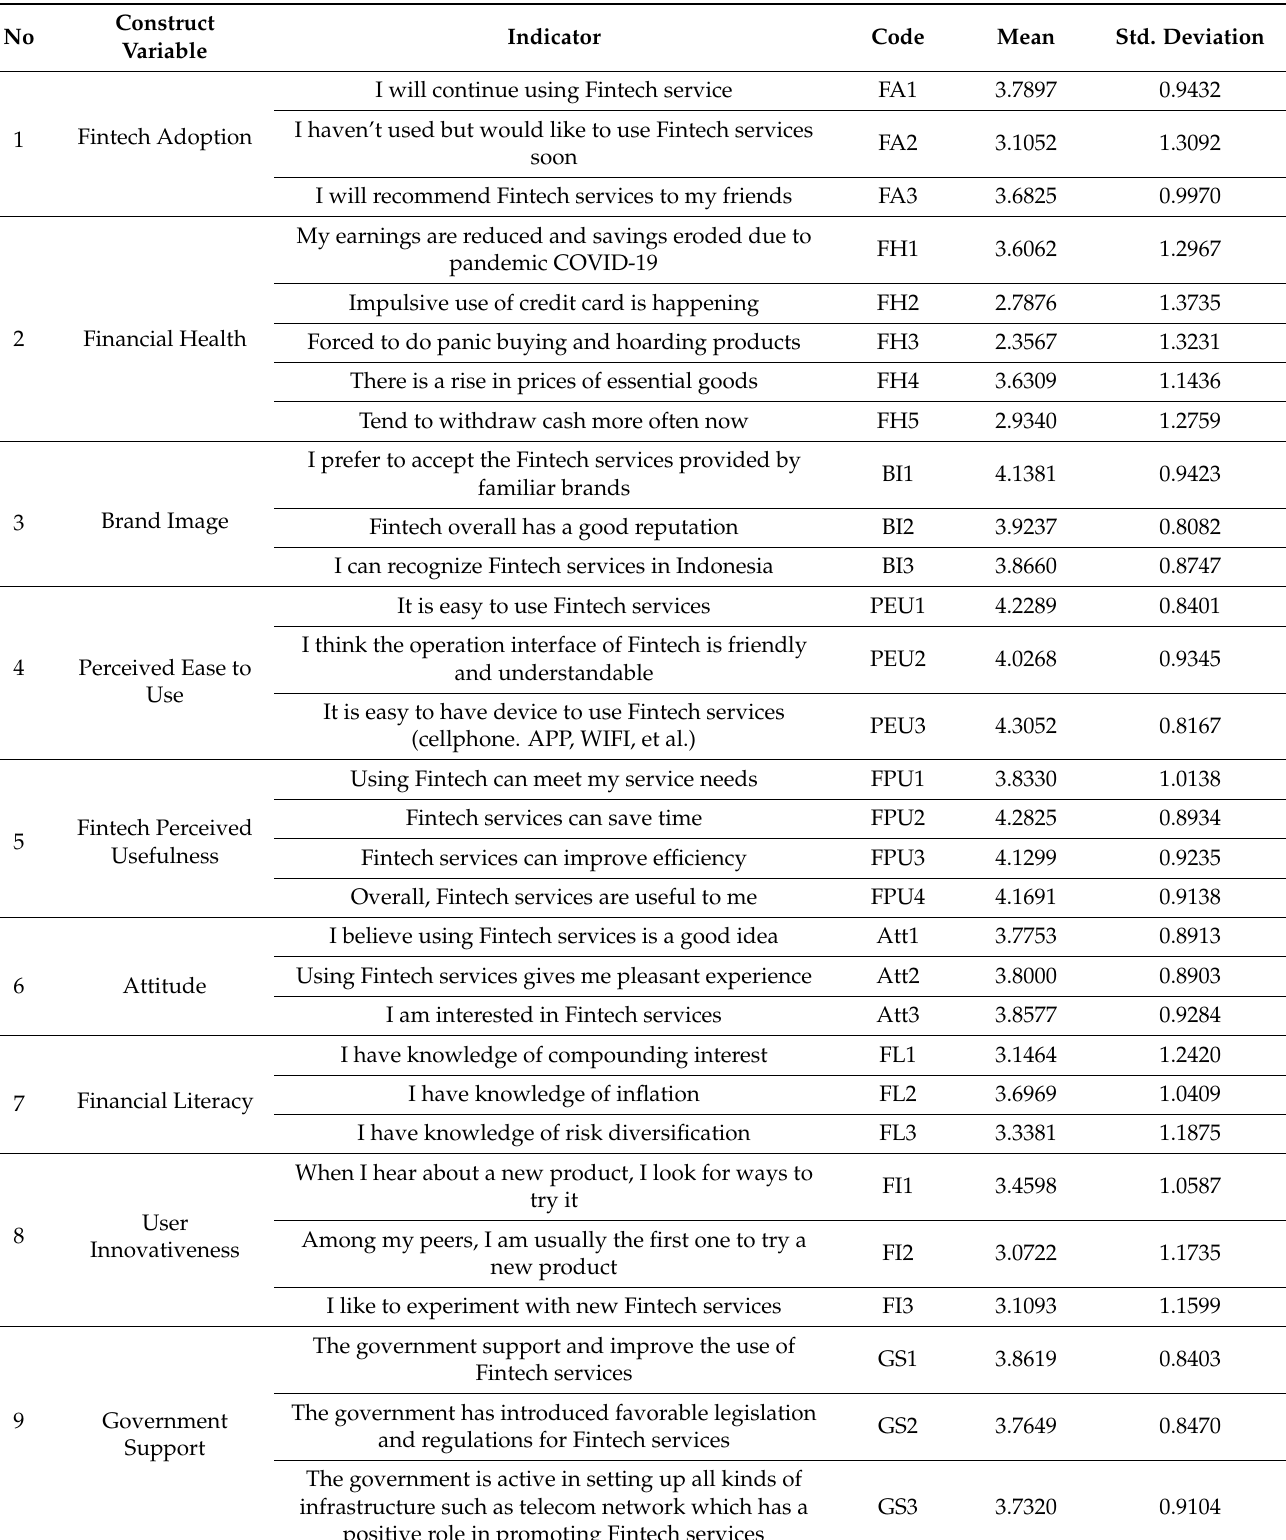
Table 3. Descriptive